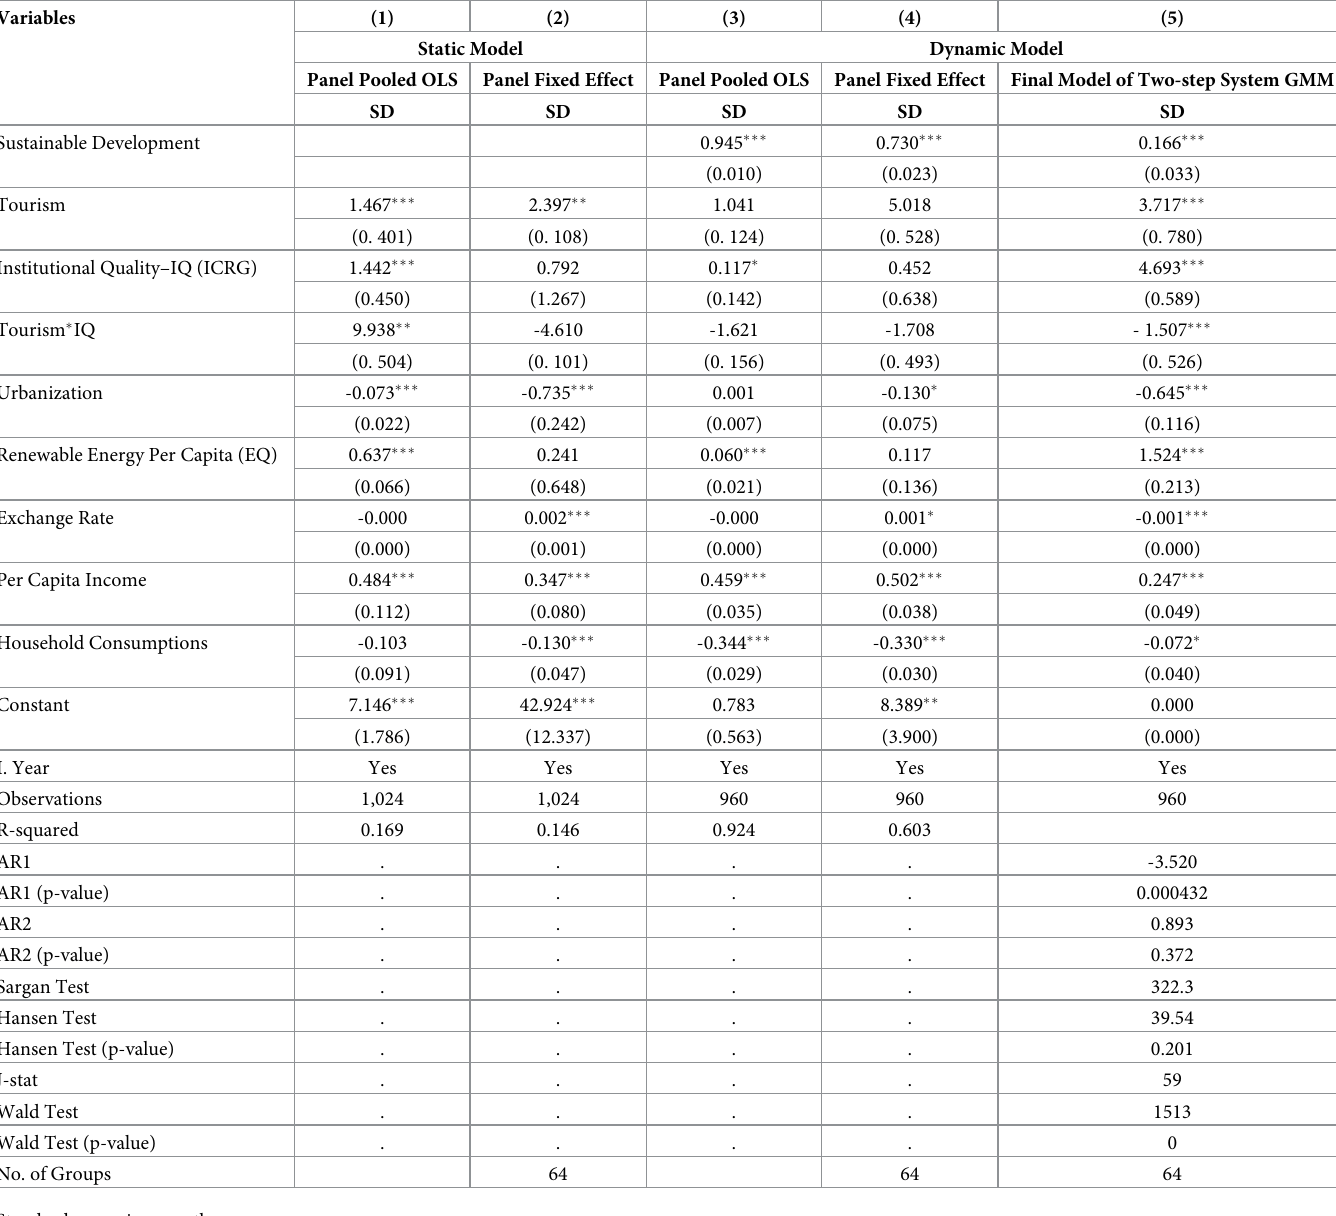
Table 7. Moderating results of IQ between tourism and sustainable development: Indirect channel.